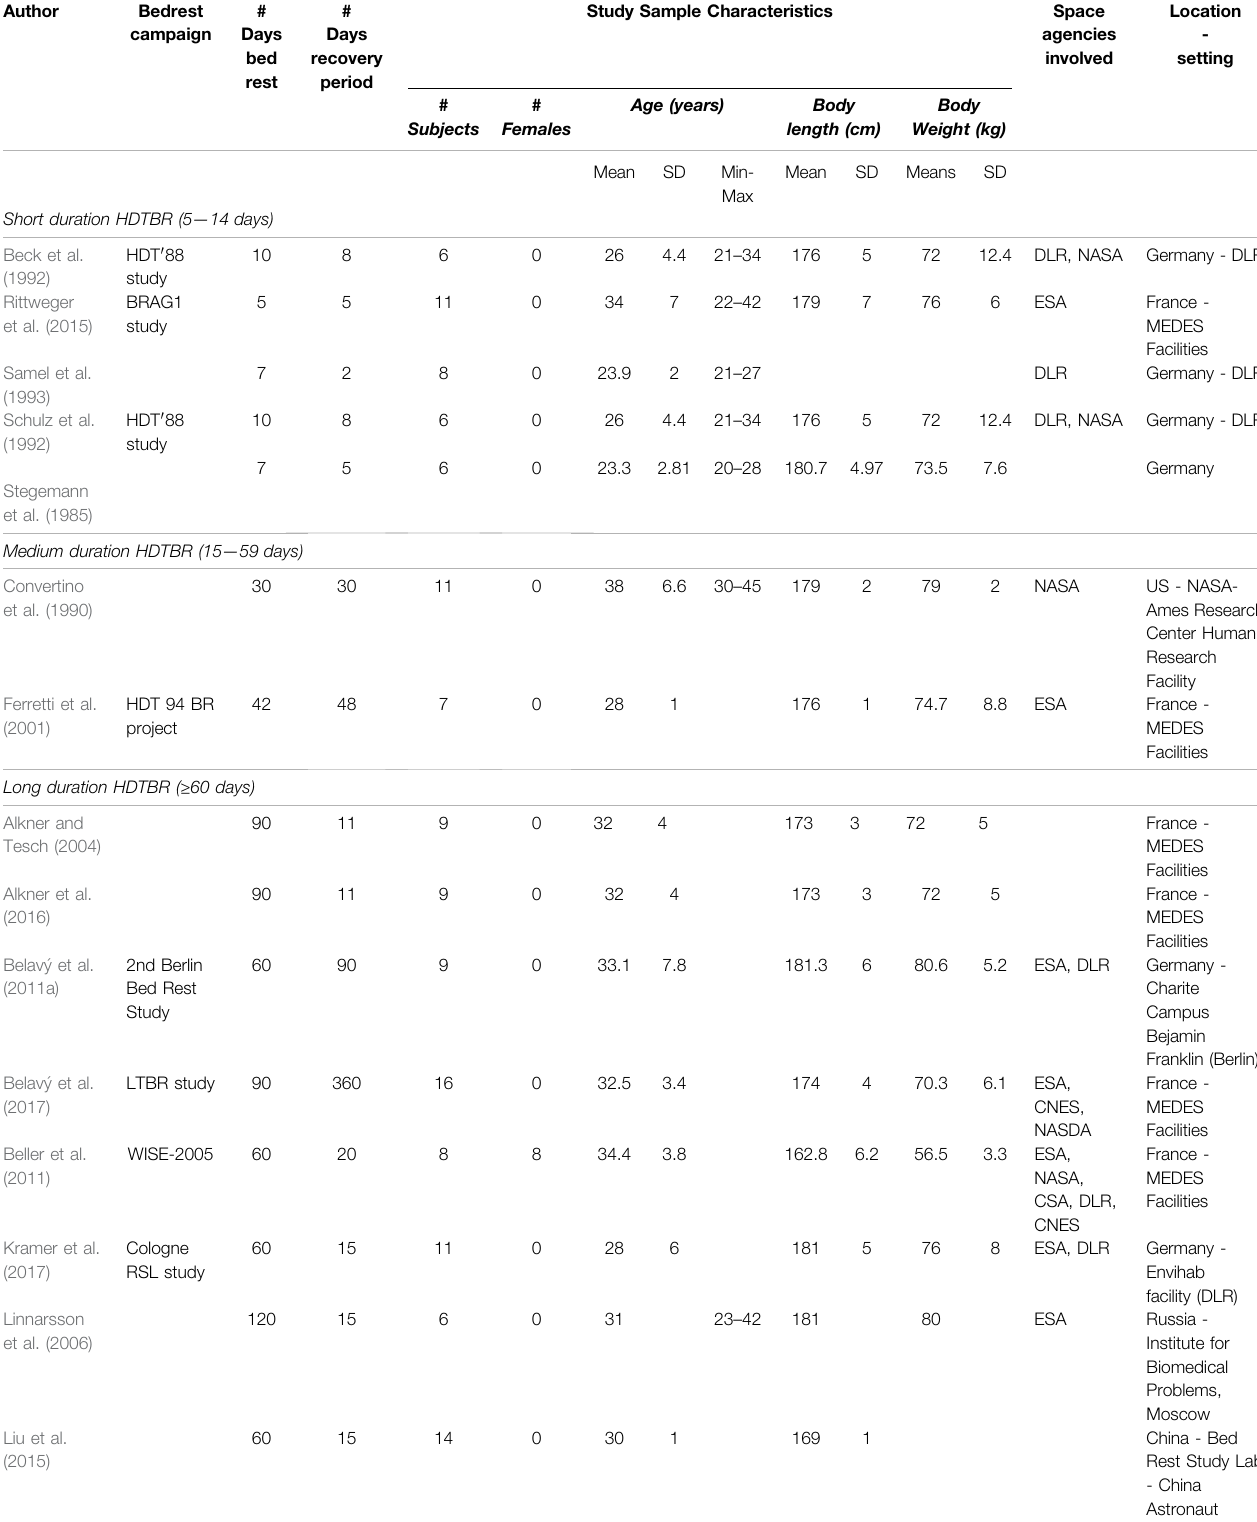
TABLE 2 | Characteristics of the individual